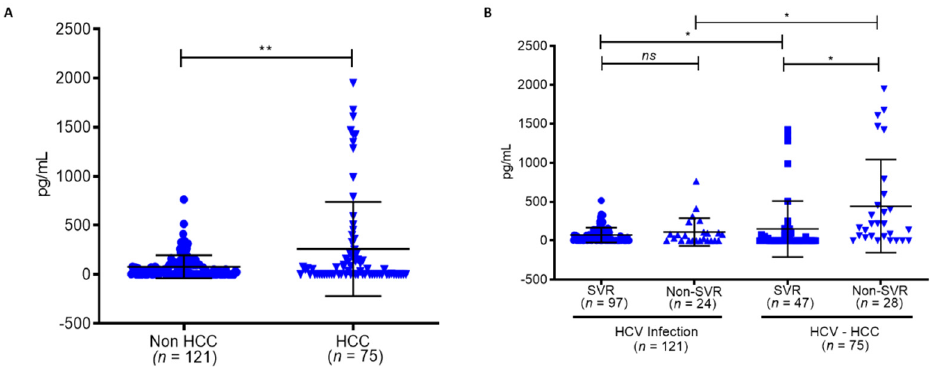
Figure 5. Kaohsiung Medical University Chung-Ho Memorial Hospital (KMUH) hepatitis C virus (HCV)-hepatocellular carcinoma (HCC) cohort ( n = 196). ( A ) CXCL8 level in non-HCC and HCC patients. ( B ) CXCL8 level in non-HCC patients with SVR and non-SVR compared to non-HCC patients with SVR and non-SVR. Statistical significance p < 0.05 *, p < 0.001 **, while values p > 0.05 were deemed non-significant (ns).